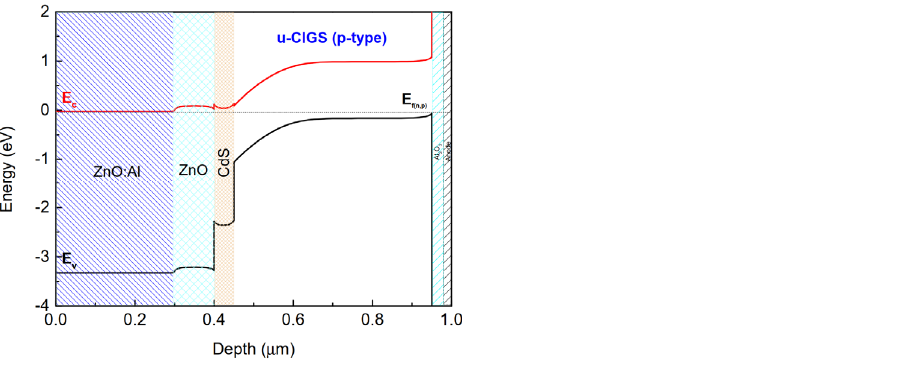
Figure 2. Schematic band diagram of ultrathin CIGS solar cell in dark conditions and equilibrium.